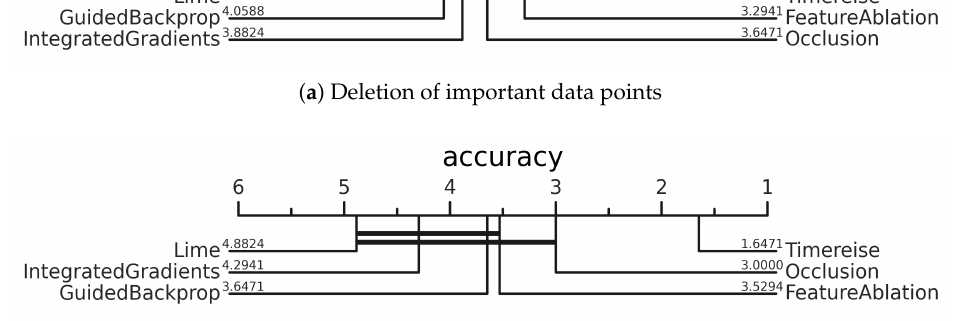
Figure 7. Deletion & Insertion. Critical difference diagram showing the average rank of each attribution method across all datasets. The ranking is based on the AUC using accuracy. Perturbation- based approaches achieve better results on the deletion and insertion test. TimeREISE shows a superior performance for both